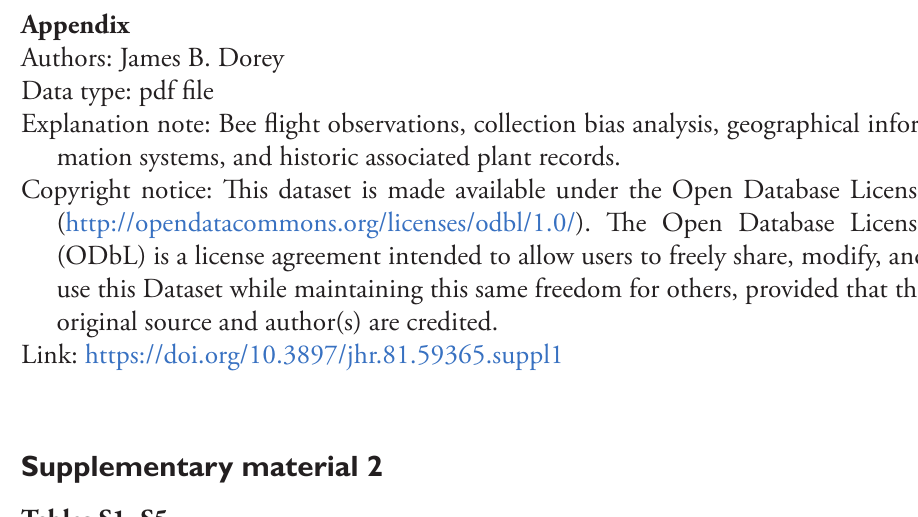
Table S2. Atlas of Living Australia data for Brachychiton acerifolius and Stenocarpus sinuatus by major vegetation subgroup (MVS) number in New South Wales and Queensland. Green highlighted rows indicate rainforest major vegetation subgroups. Table S3. Collection data from New South Wales and Queensland. Table S4. Major vegetation subgroup (MVS) data including MVS number, MVS name. Measure- ments include total MVS area (km 2 ) and proportions, and sampled MVS area (km 2 ) and proportions. Sum of the number of bees, sample time and the total area of NSW and QLD for each MVS are also included. Table S5. Summary of fragmentation statistics for the two bioregions, the Wet Tropics and Central Mackay Coast